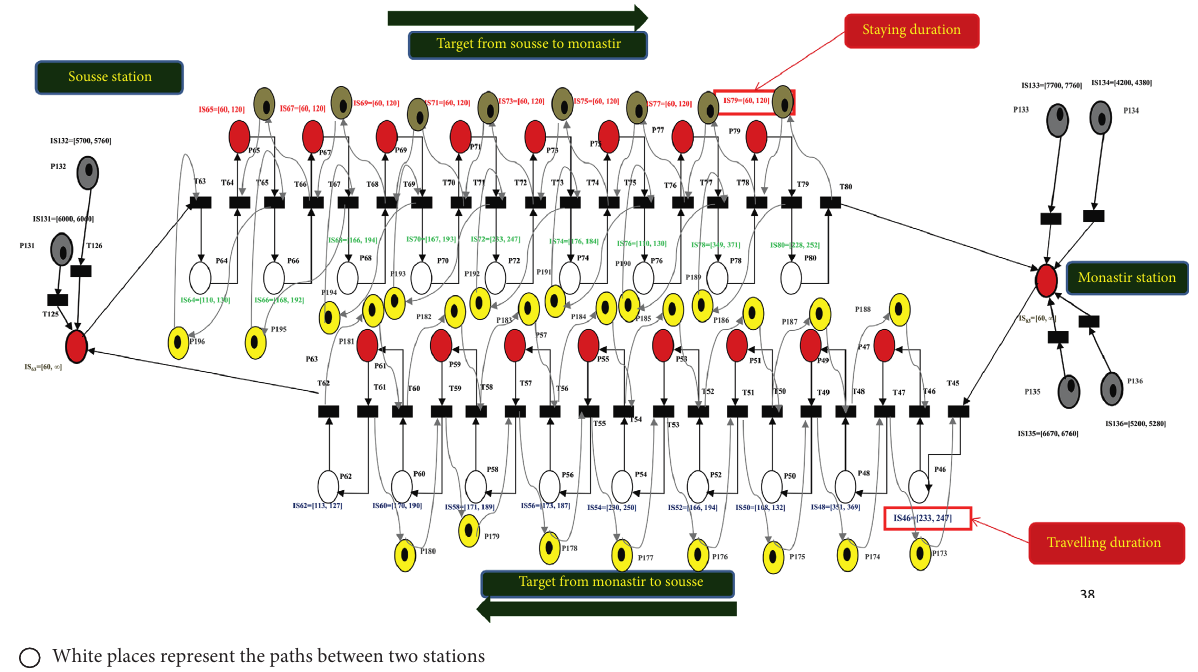
White places represent the paths between two stations Red places represent the stations Yellow resource places indicate the direction of train circulation Gray places represent two resources to avoid the collision and the crossover of the two trains Figure 3: SP-TPN model for the railway network